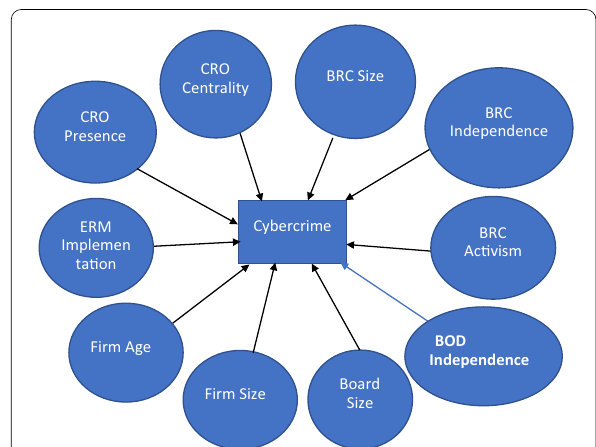
Fig. 1 Conceptual model. Source : Developed by